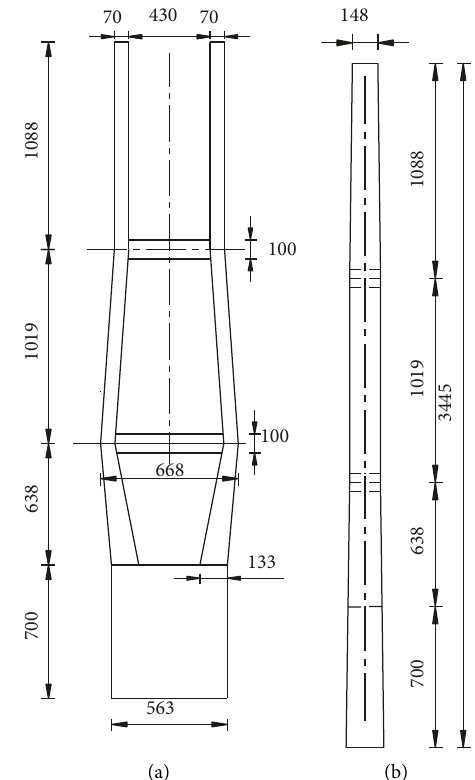
Figure 6: Across and axial direction view of the tower/mm: (a) bridge in across direction and (b) bridge in the axial direction.